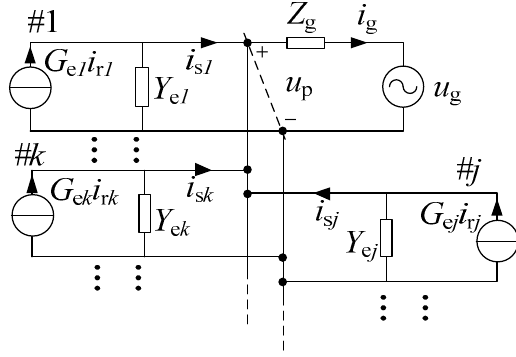
Figure 5. System equivalent Norton model.